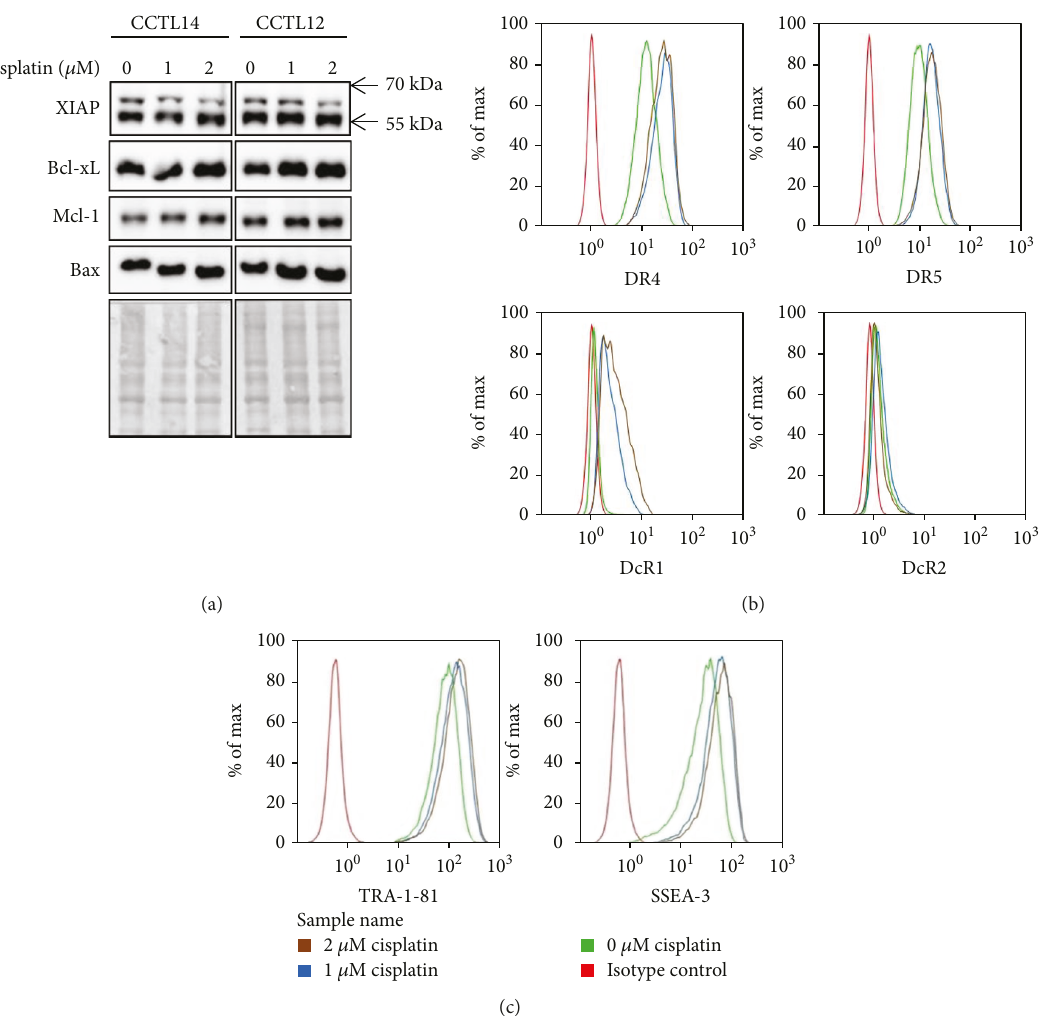
Figure 3: A sublethal dose of cisplatin modulates the expression of death receptors and initiator caspases. Cells treated with 1 μ M and 2 μ M doses of cisplatin for 24 hours were assessed for the expression of key apoptotic signaling components and pluripotency-associated markers. (a) Western blot analysis of pro- (Bax) and antiapoptotic proteins (XIAP, Bcl-xL, and Mcl-1) involved in the regulation of the intrinsic apoptotic pathway. Staining with 0.1% amidoblack was used to evaluate the protein loading. Both CCTL12 and CCTL14 lines of hESC were used ( n = 2 ). (b) Expression of cell membrane-linked death receptors with an a ffi nity to TRAIL and (c) expression of pluripotency-associated membrane markers, as determined by fl ow cytometry. At least 10,000 cells were analyzed per sample. Red line — isotype control, green line — control cells without cisplatin, blue line — cells treated with 1 μ M cisplatin, and brown line — cells treated with 2 μ M cisplatin. Both CCTL12 and CCTL14 lines of hESC were used ( n = 2 ); a representative picture is